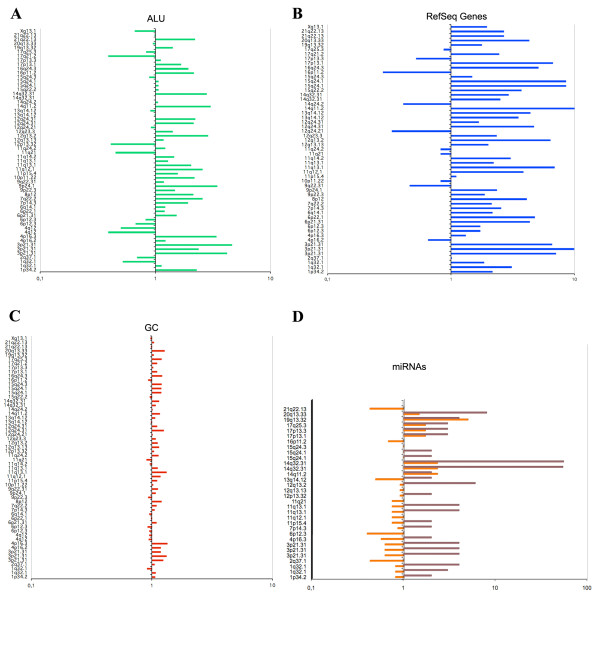
Histograms representing the frequency distribution of genomic features in the breakpoint regions. All values shown for Alu (A), RefSeq Genes Item count (B), GC (C), and miRNAs (D) are reported in logarithmic scale. Chromosomal bands with a null value were excluded from the analysis. The observed distribution of miRNAs within 4 Mb intervals (brown) was compared to the expected mean value for each chromosome (orange).